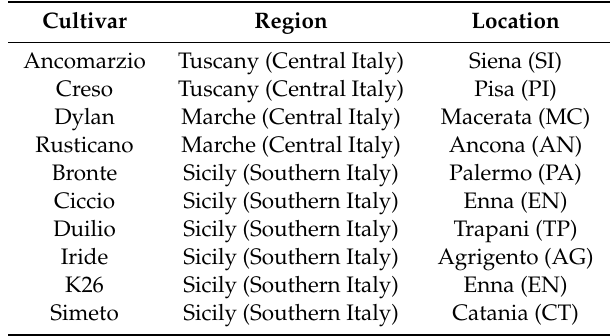
Table 1. Durum wheat sample specifications: cultivar, region and